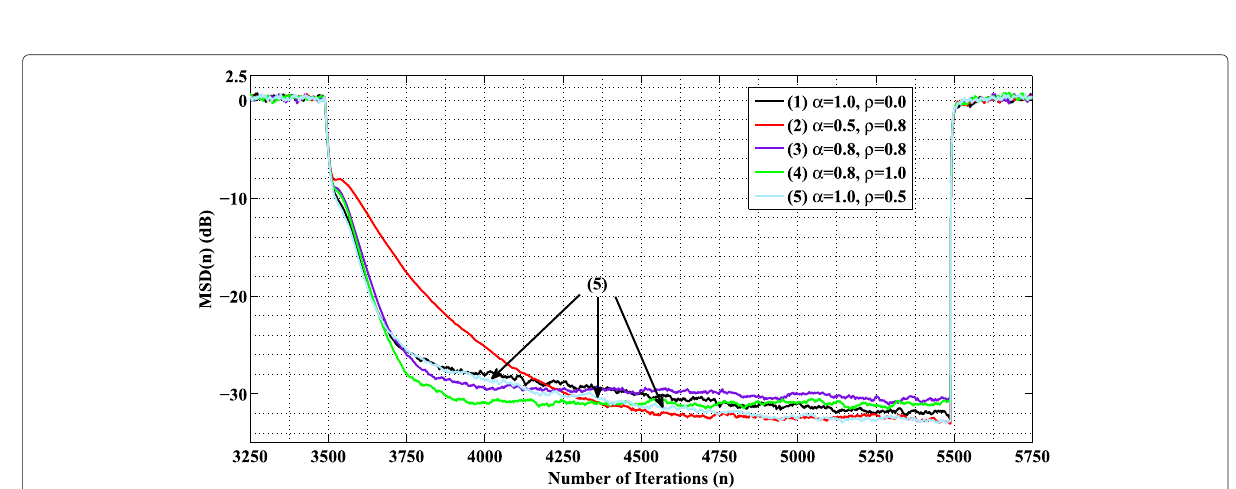
Fig. 21 Effect of using both transfer and momentum terms on the MSD performance of the D-CFLF scheme when input signal is white